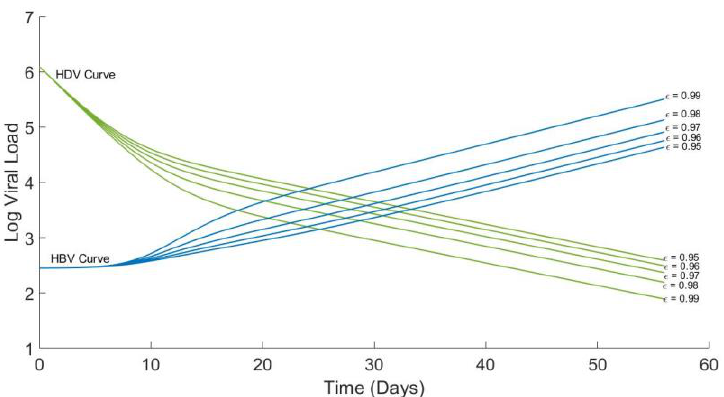
Figure A5. One-way sensitivity analysis on the impact of parameter ε on predicted HBV/HDV kinetics under anti-HDV treatment. Model parameters were set to D 0 = 1,202,260, B 0 = 282, κ = 26,137, c = 0.47, n = 1.25, τ = 0.1, and g = 0.094, with ε being set at ε = (0.95, 0.96, 0.97, 0.98, 0.99).